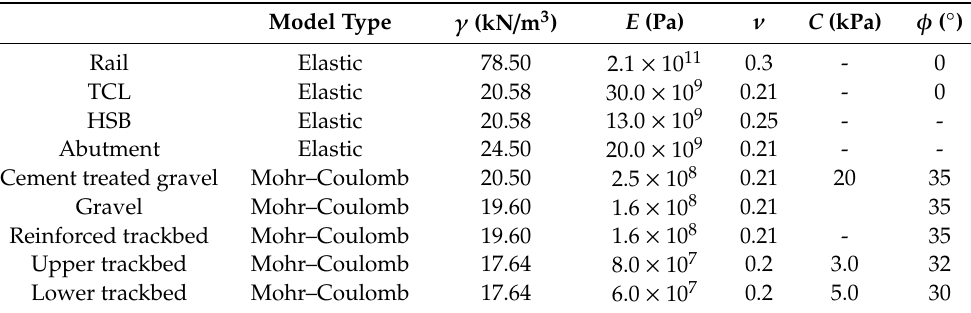
Table 2. Material properties of track model.